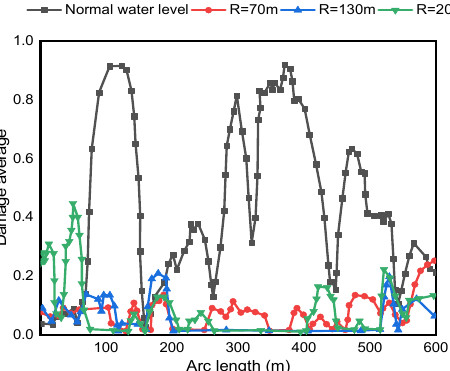
Figure 23. Damage curves for dam crests at various water levels in front of the dam. The maximum displacement value, maximum velocity value, and maximum acceler- ation value in the entire dynamic time history of each monitoring point at the arch crown beam are extracted, respectively, to further investigate the dynamic response of the dam body under different water levels in front of the dam, as shown in Figure 24, where R represents the decreased degree of water level.